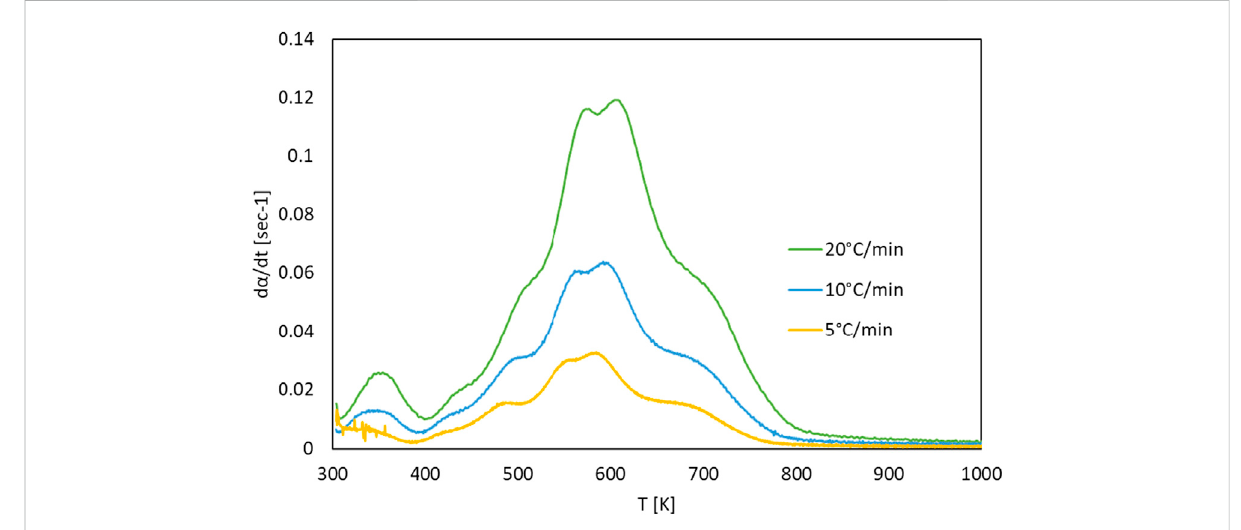
FIGURE 5 DTG curves of G. pectorale at different heating rates.